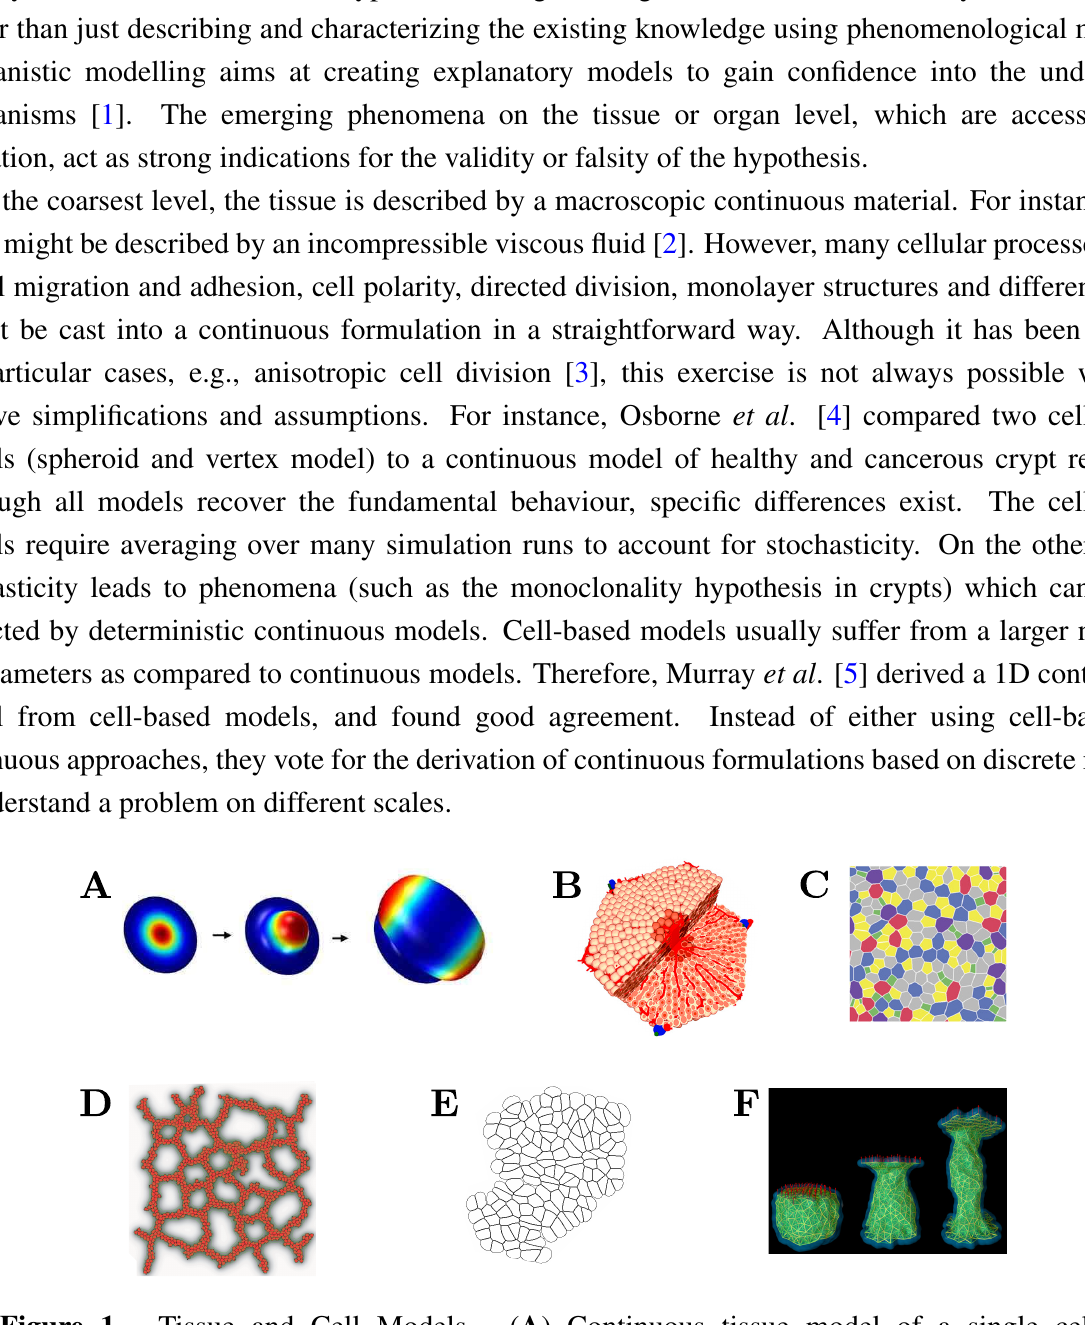
Figure 1. Tissue and Cell Models. ( A ) Continuous tissue model of a single cell layer to simulate tip growth and branching, where the surface is displaced in normal direction according to the local signal concentration (reprinted with permission from [6]); ( B ) Spheroid model of a liver lobule (reprinted with permission from [7]); ( C ) Vertex model to study epithelial dynamics (reprinted by permission of Elsevier from [8]); ( D ) Cellular Potts model of blood vessel growth (reprinted with permission from [9]); ( E ) Immersed Boundary cell model of a proliferating tissue; ( F ) Subcellular Element model of a single cell subject